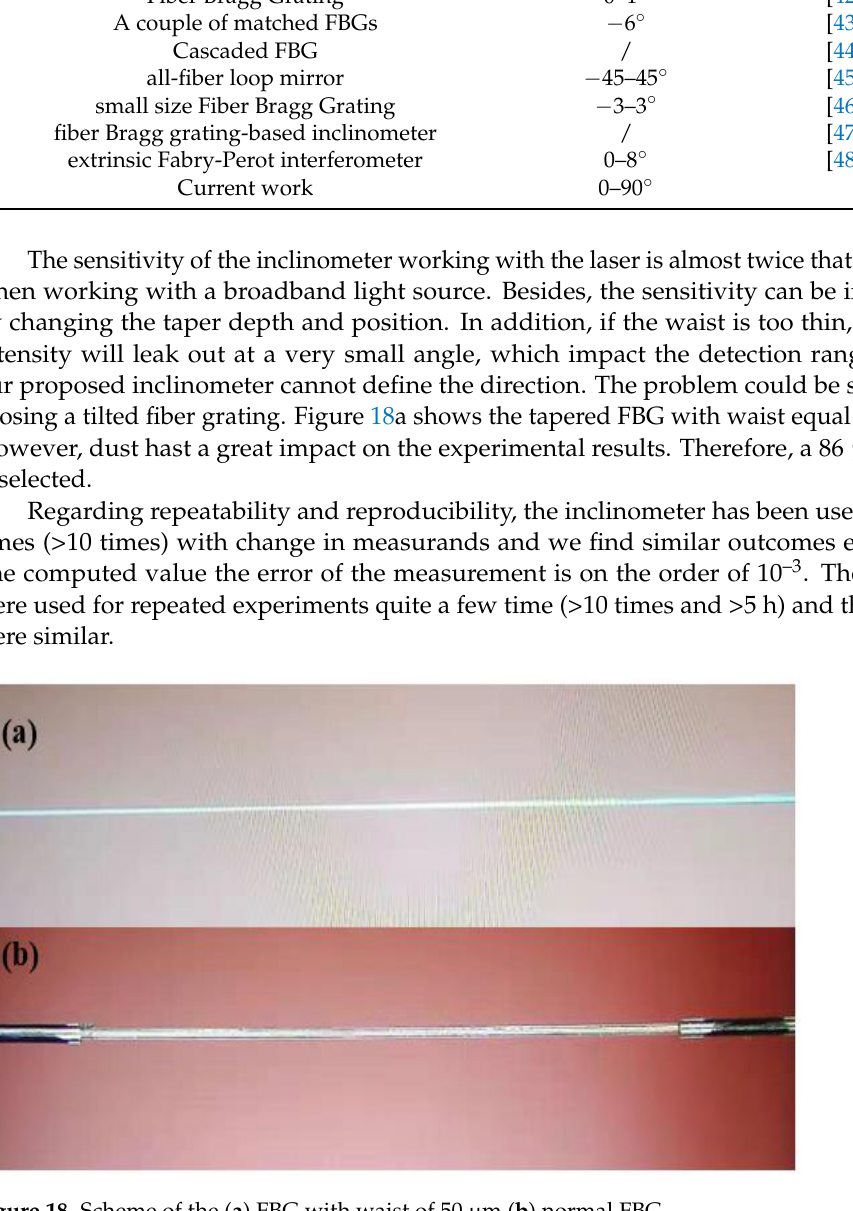
Figure 18. Scheme of the ( a ) FBG with waist of 50 µm ( b ) normal FBG.